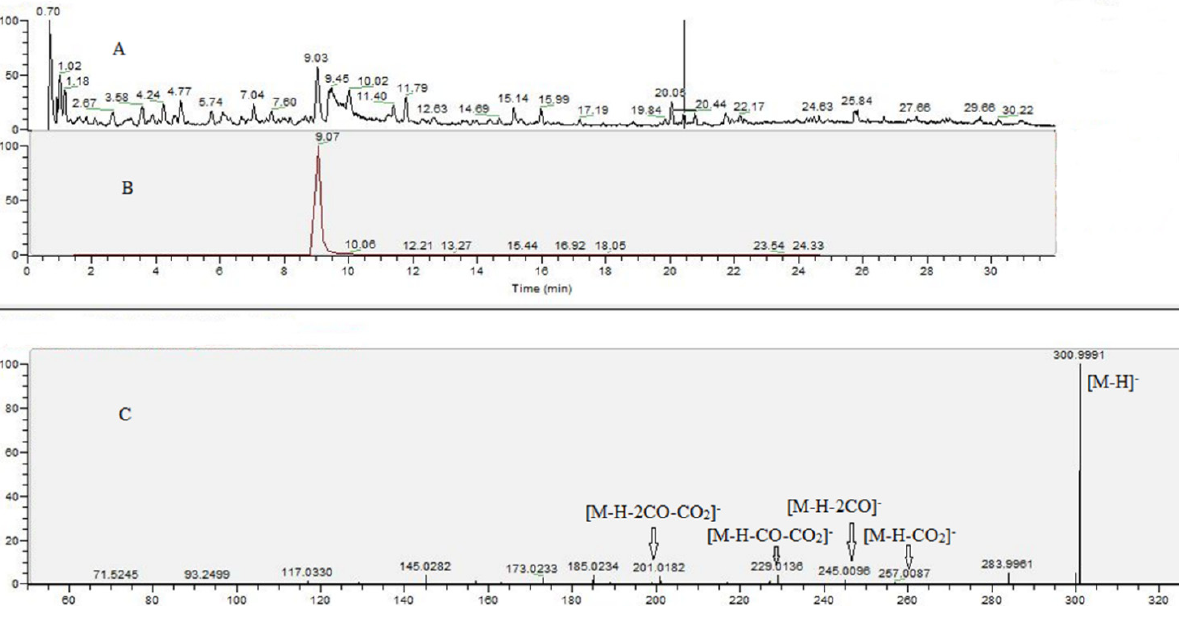
Figure 4. Total ion chromatogram in negative ion mode ( A ), extracted ion chromatogram of peak at Table 5. Profile of secondary metabolites of G. urbanum (EtOAc-AP) by UHPLC–HRMS.